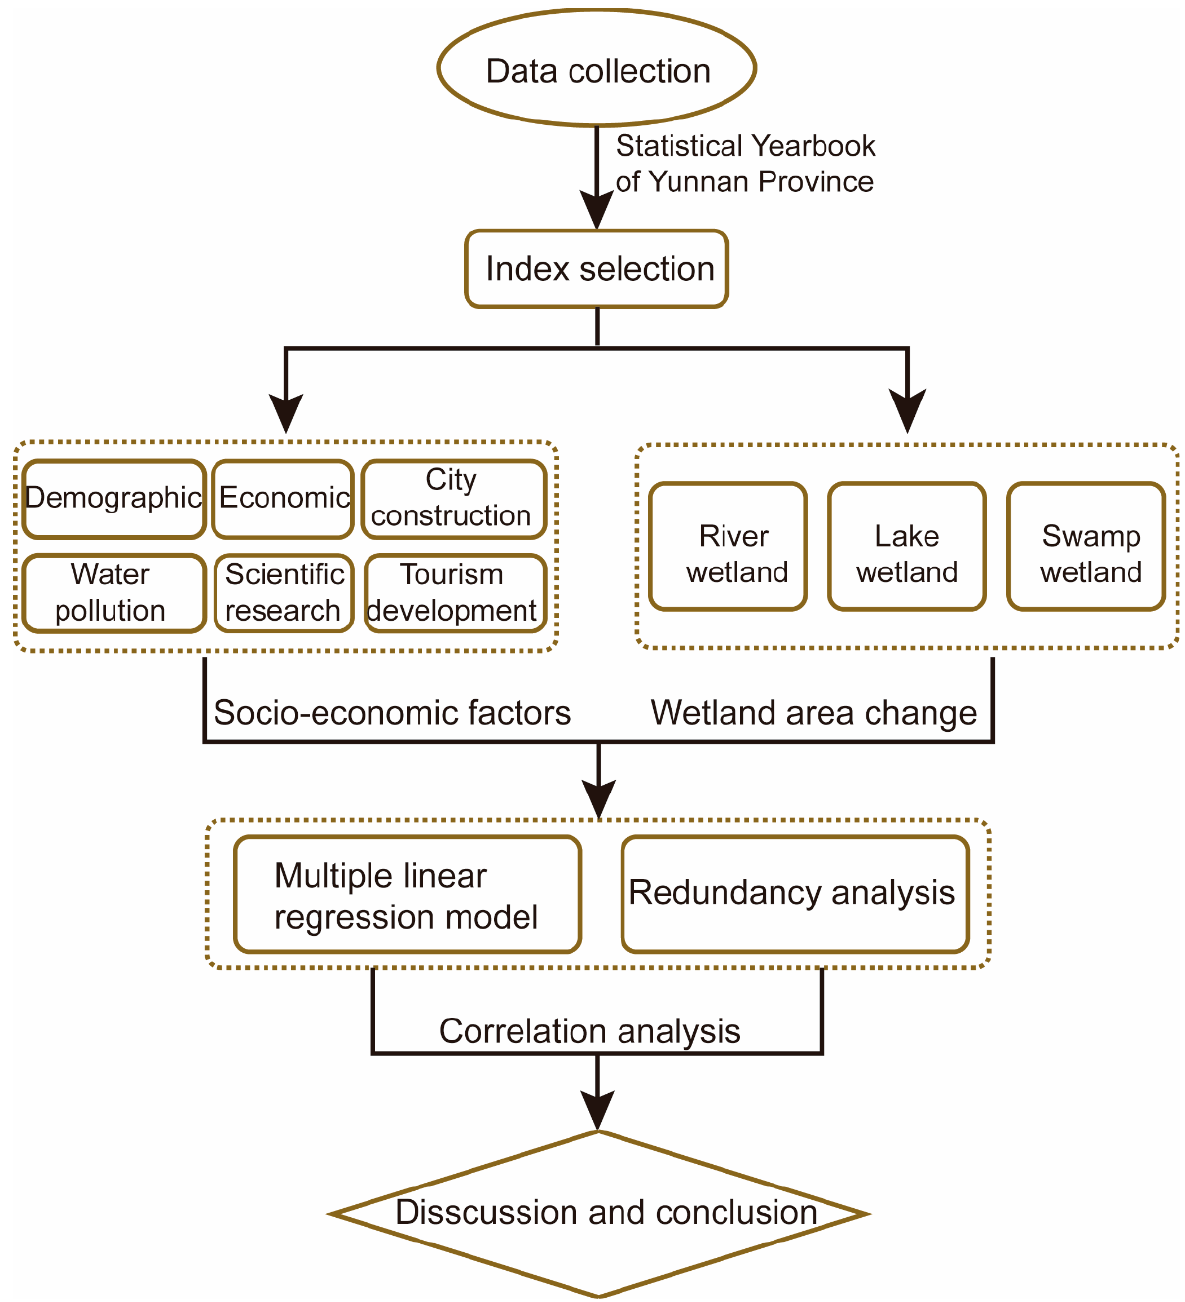
Figure 2. Flowchart of the analysis of socio-economic factors influencing the wetland area change.